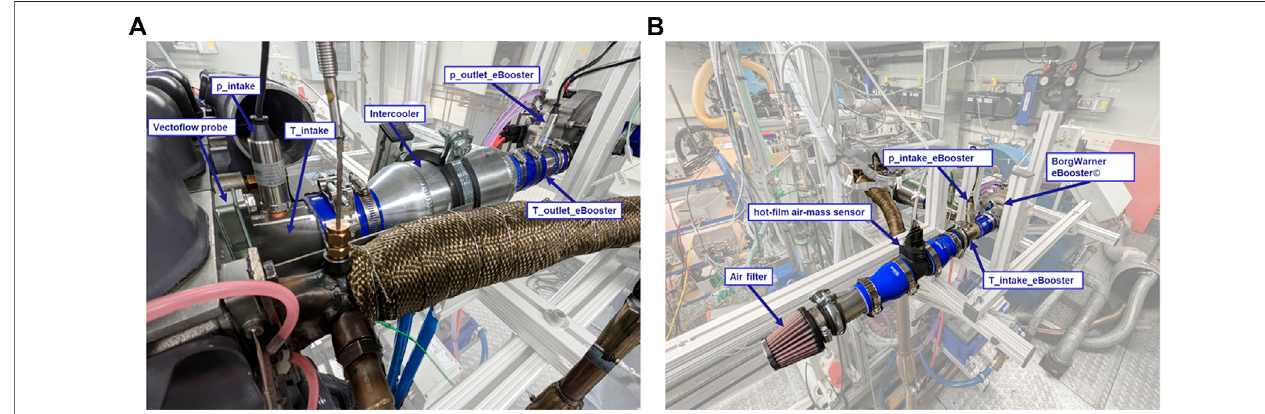
FIGURE 1 | (A) Intake System after eBooster © Outlet, (B) Intake System in front of eBooster ©